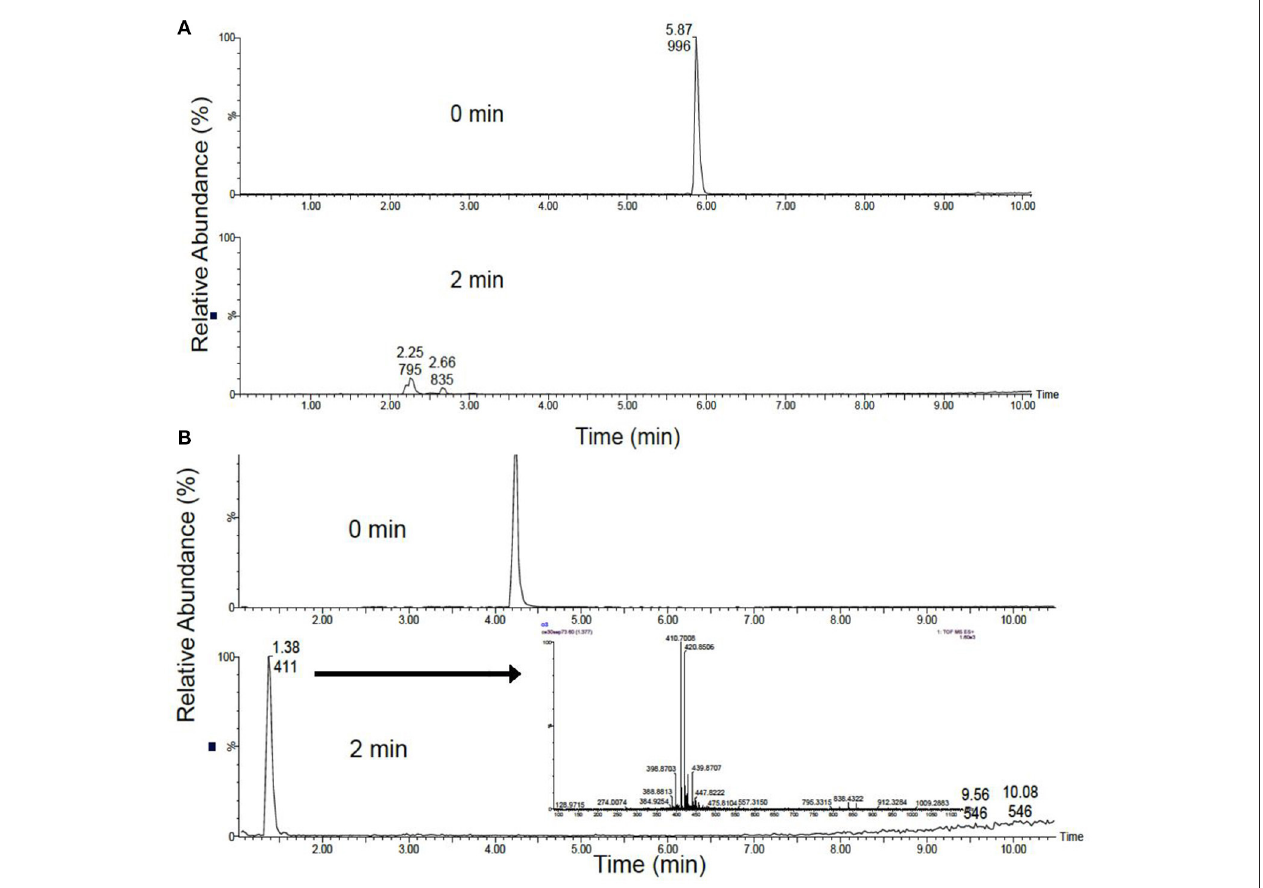
FIGURE 2 | Scaled total ion chromatograms at a flow rate of 1L min − 1 , equivalent to 0.199 ppm O 3. (A) MC-LR before (top) and after 2m (bottom) of treatment (B) MC-RR before (top) and after 2m (bottom) of treatment. Inset: The spectra of unknown intermediates, unseparated peaks were detected in the void volume, m/z 411 and